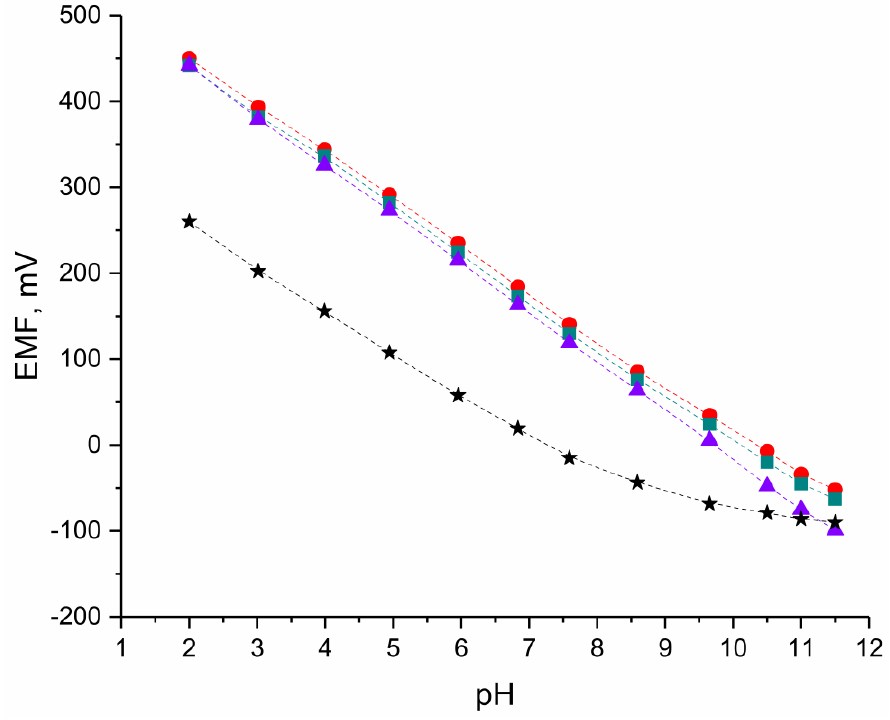
Figure 2. Exemplary potentiometric response • -GC/hIrO 2 /H + -ISM, (cid:4) -GC/hIrO 2 +NTs/H + -ISM, (cid:78) -GC/hIrO 2 +NTs+POT/H + -ISM and -GC/pH- ISM electrode after 24 h of electrodes’ conditioning in pH 3.